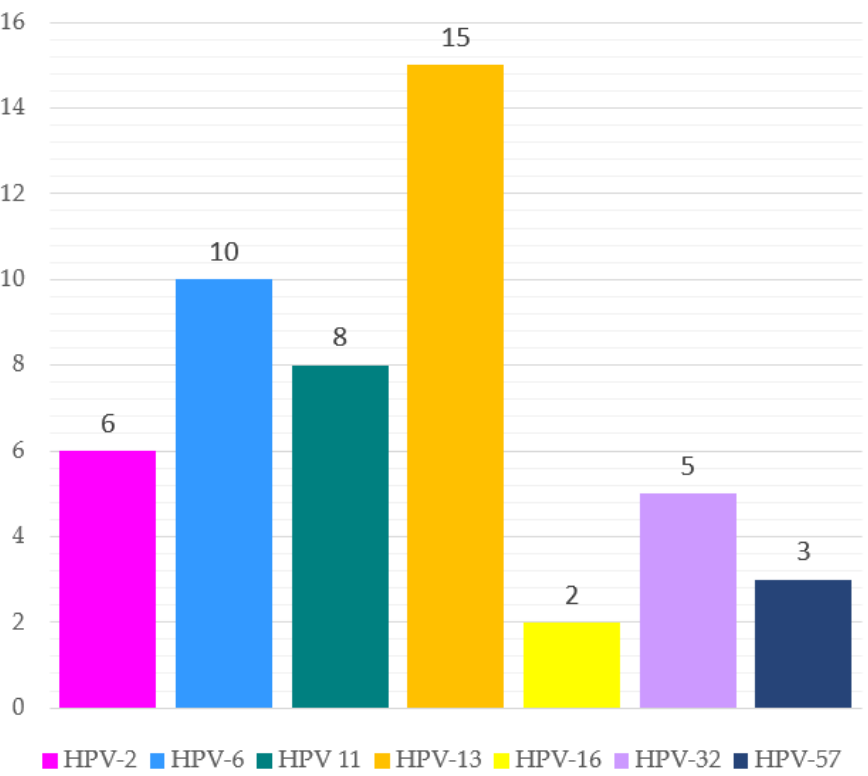
Figure 3. Frequency of viral genotypes detected in HPV-related oral lesions in pediatric patients.